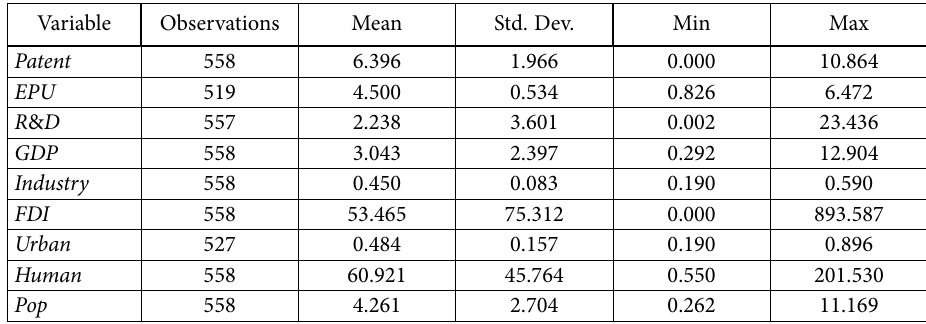
Table 2. Data description